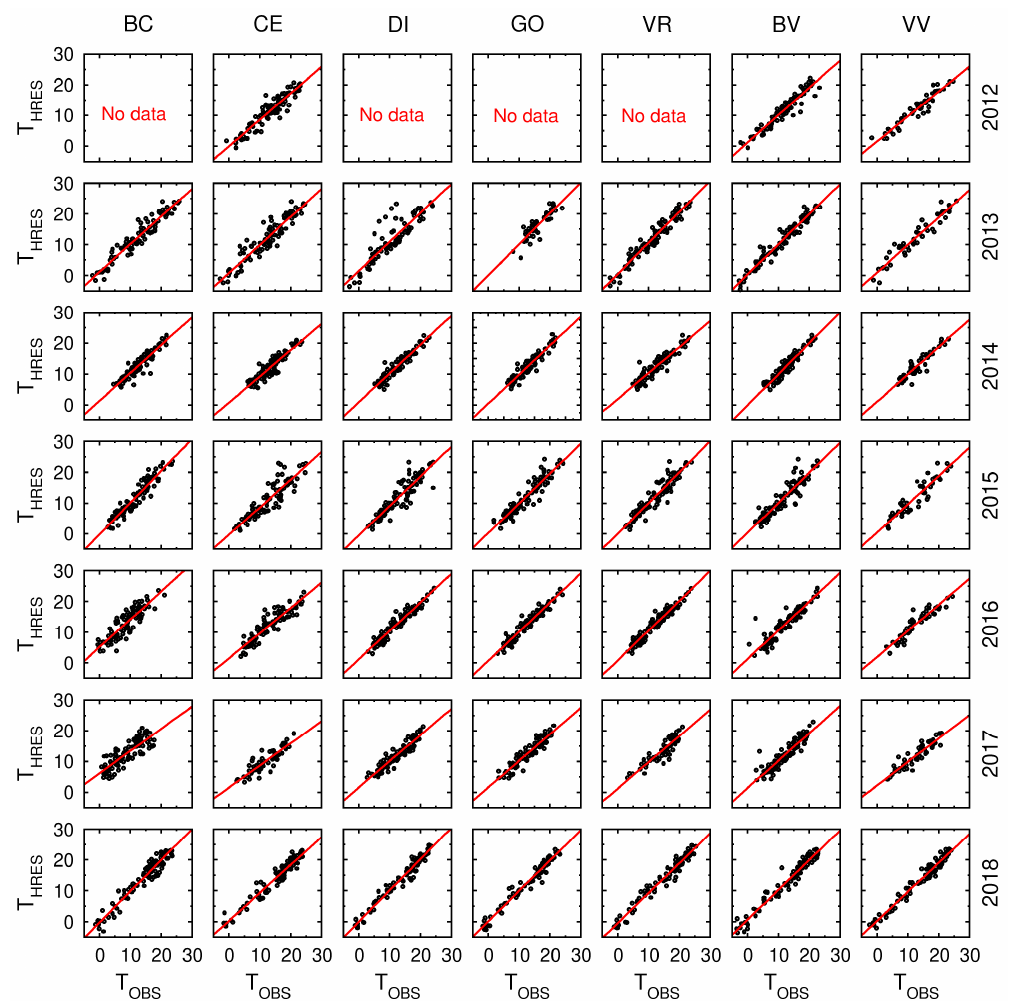
Figure 1. Comparison between observed (T OBS ) and predicted daily air temperatures in ◦ C by high-resolution atmospheric forecast model (HRES) (T HRES ) for selected locations during March, April, and May (MAM) 2012–2018.